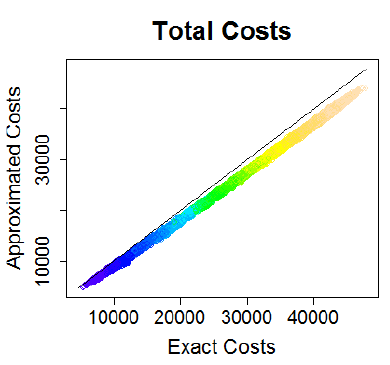
Figure 6. Comparison of cost approximations for metal sheets; the colors indicate the number of segments, starting at the bottom left with 4 segments (dark blue) to the top right with 23 segments